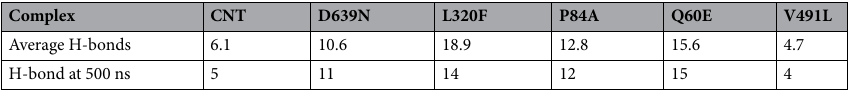
Table 5. The average of H-bond interactions between the SARS-CoV-2 spike and ACE 2 in the last 50 ns of simulation time.